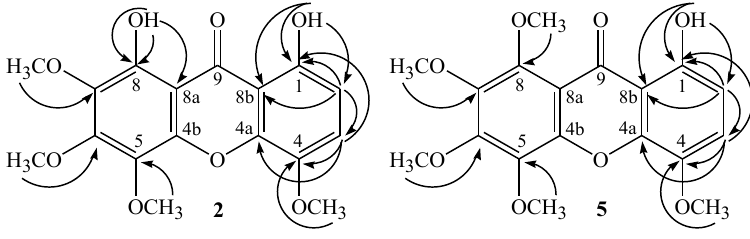
Figure 2. HMBC correlations (H→C) of compounds 2 and 5 .